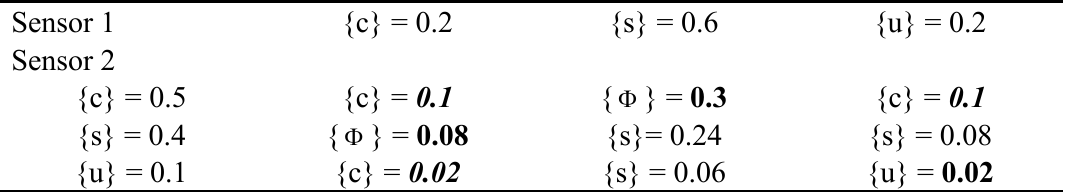
Table 1. Intersections and products of two sensor’s basic belief